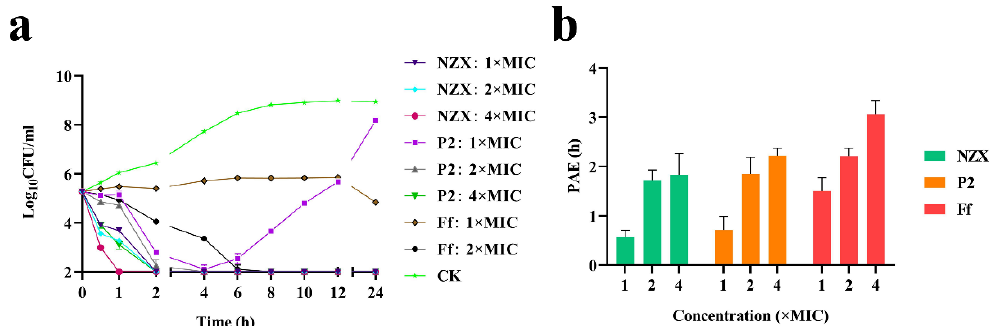
Figure 1. Time-killing curves and PAE. ( a ) Time-killing curves of NZX and P2 against S. agalactiae ACCC 61733. The S. agalactiae cells were treated with NZX and P2 (1×, 2×, or 4× MIC) at 250 rpm and 37 °C for 2 h , respectively. A 100 μL of the sample was taken for colony counting on TSA plates at different time points of 0 – 24 h. ( b ) PAEs of NZX and P2 to S. agalactiae ACCC